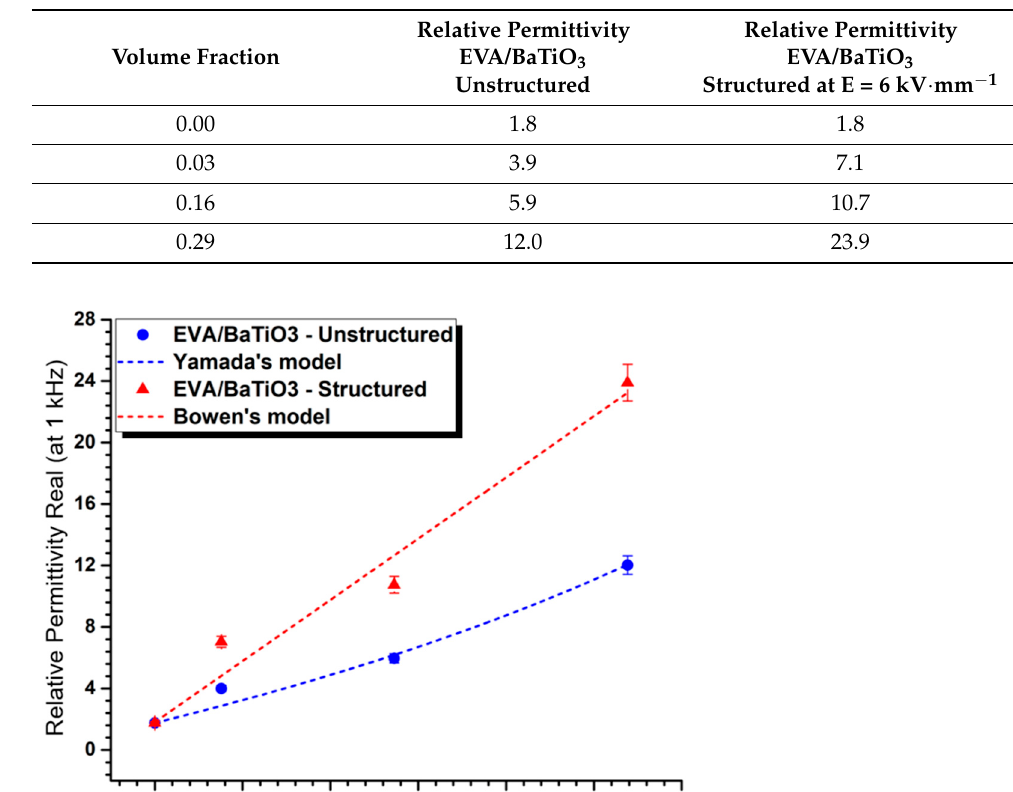
Table 2. Relative dielectric permittivity at 1 kHz, as a function of BaTiO 3 volume content for unstructured 0–3 configuration, and dielectrophoretically structured 1–3 configuration.